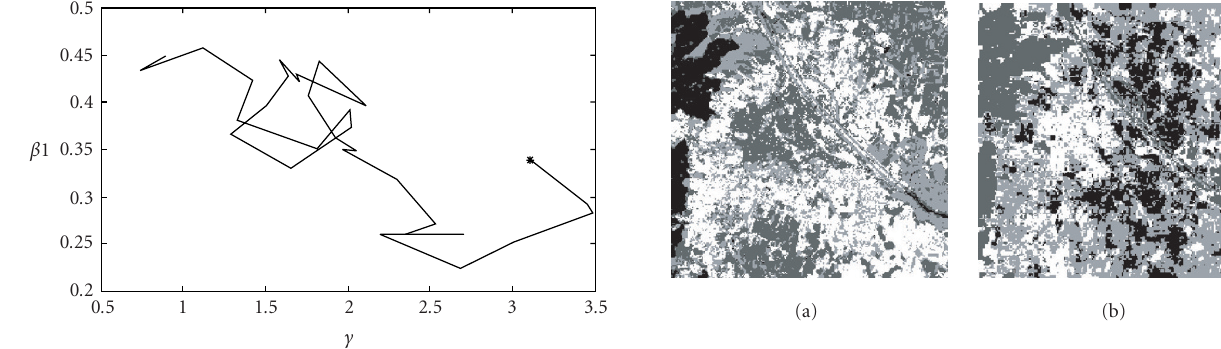
Figure 4: The relation between proportion γ and β 1 .